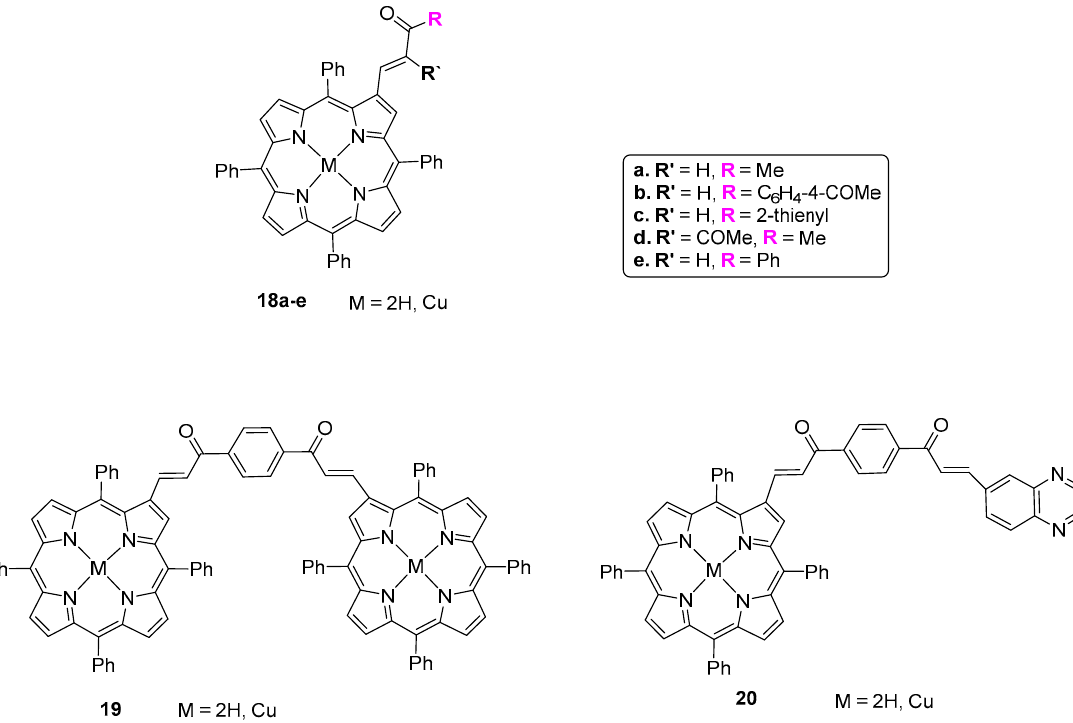
Figure 8. Structures of α , β -unsaturated derivatives obtained from the condensation of β -CHOTPP 3 with the adequate ketones [105,106].